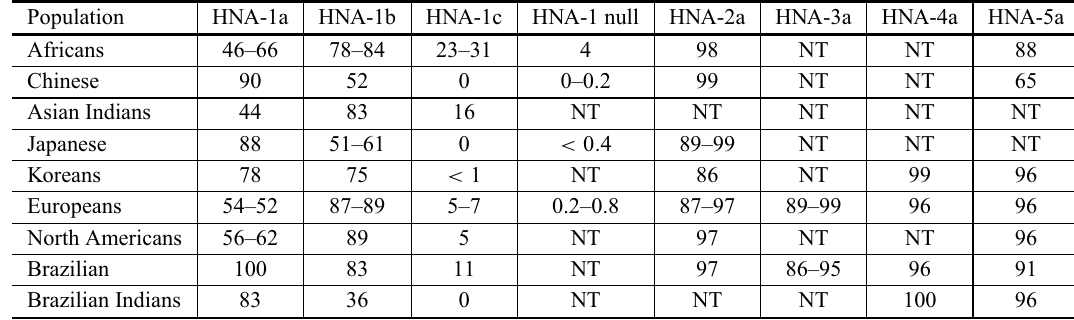
Human neutrophil alloantigens (HNA) frequencies